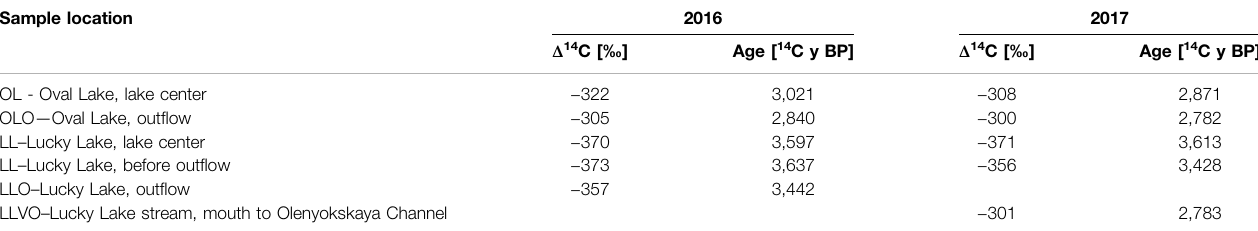
TABLE 2 | Results of the radiocarbon analyses of DOC samples collected in July and August 2016 and July 2017. Sample